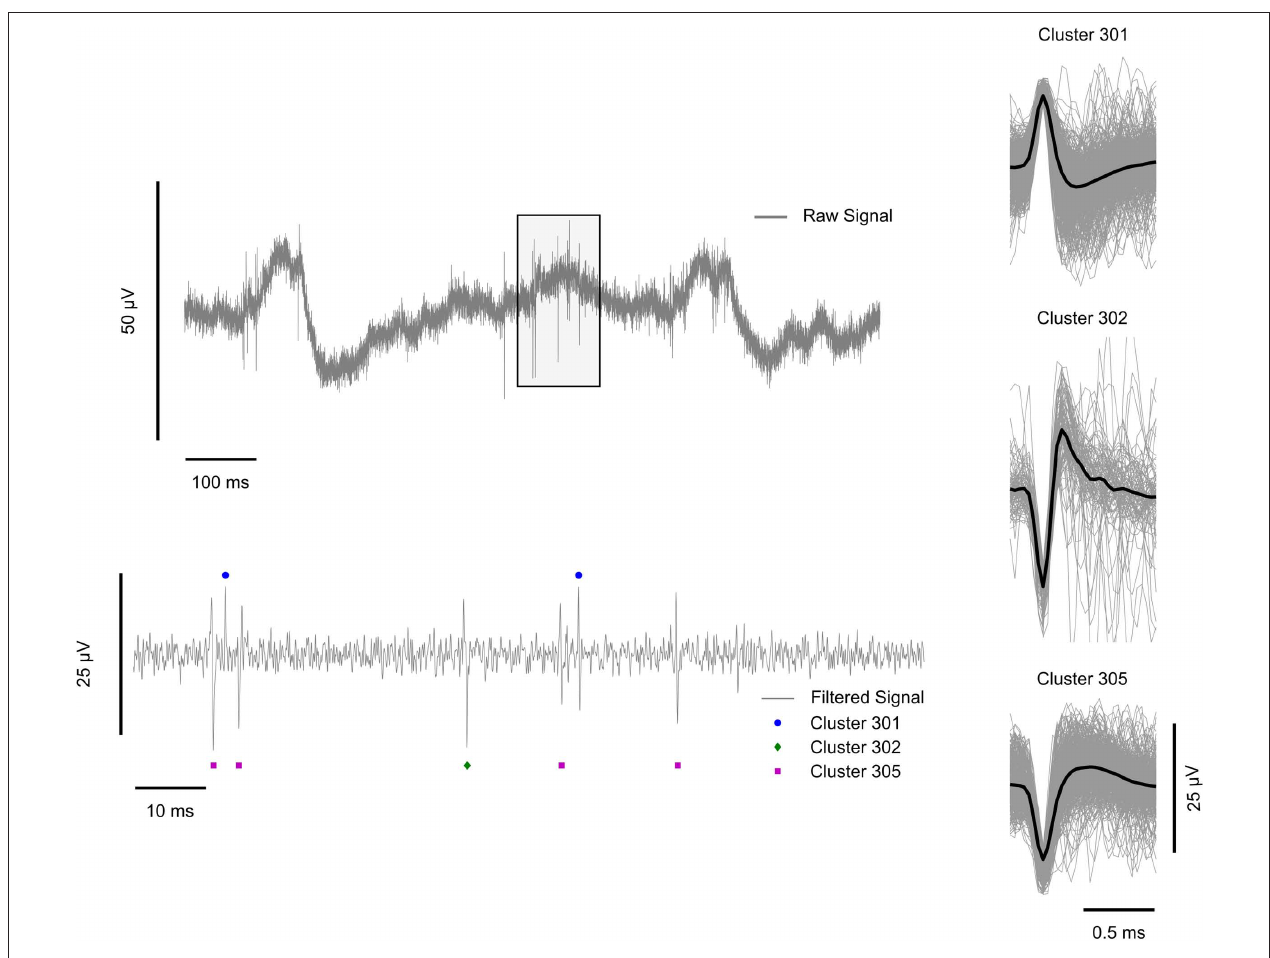
302, and squares cluster 305. Cluster identifiers correspond to the cluster label (tens and ones digits) per analysis stream (hundreds digit). In this example, clusters 1, 2, and 5 are shown from analysis stream 3. Right: Average clustered spike event waveforms (black) with individual spike event waveform traces in gray for three representative